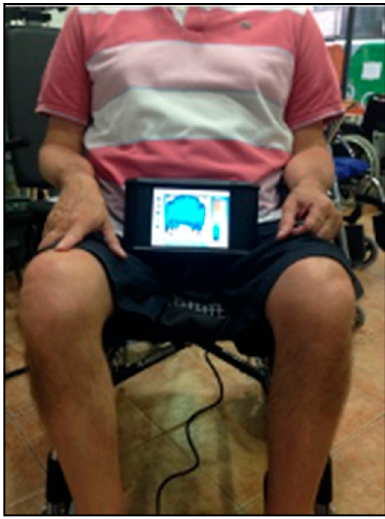
Figure 2. Participant during the measurement moment with pressure mapping.